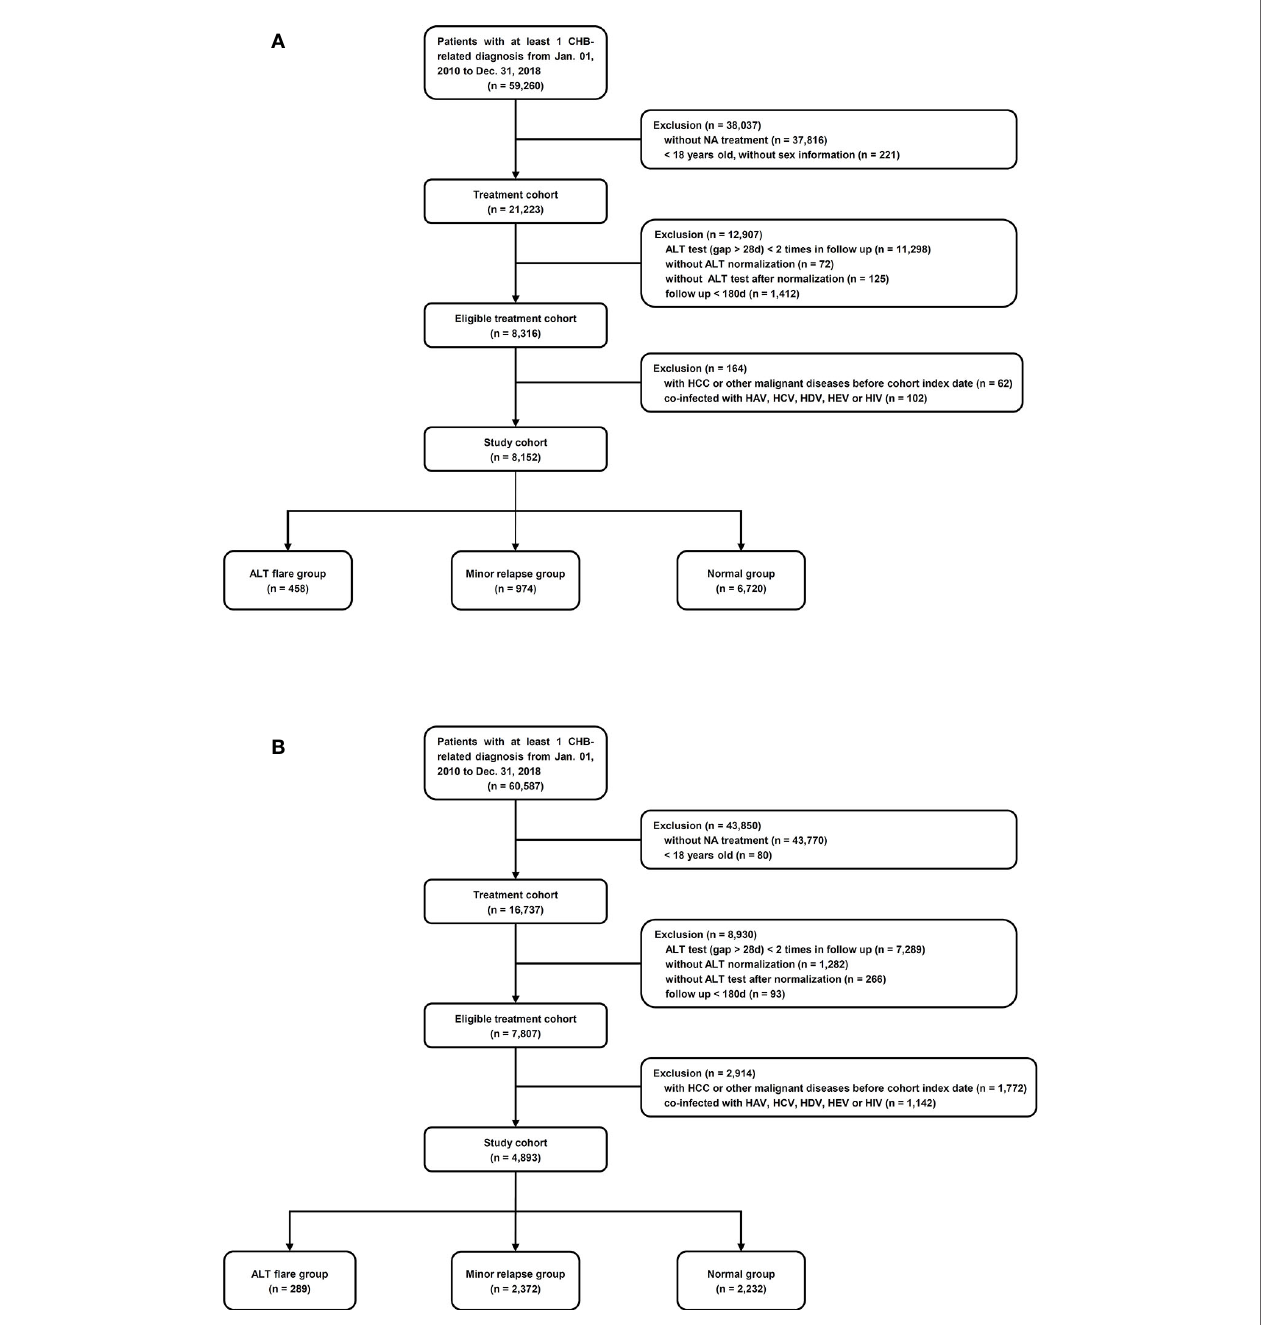
FIGURE 1 | Cohort selection. (A) Ruijin Hospital, China. ALT fl are group: ALT relapsed to ≥ 128 U/L; minor relapse group: ALT relapsed to 64 – 128 U/L; normal group: ALT achieved and maintained ≤ 64 U/L. (B) Optum EHR database, the US. ALT fl are group: ALT relapsed to ≥ 175 U/L in men and ≥ 125 U/L in women; minor relapse group: ALT relapsed to 35 – 175 U/L in men, 25 – 125 U/L in women; normal group: ALT achieved and maintained ≤ 35 U/L in men, ≤ 25 U/L in